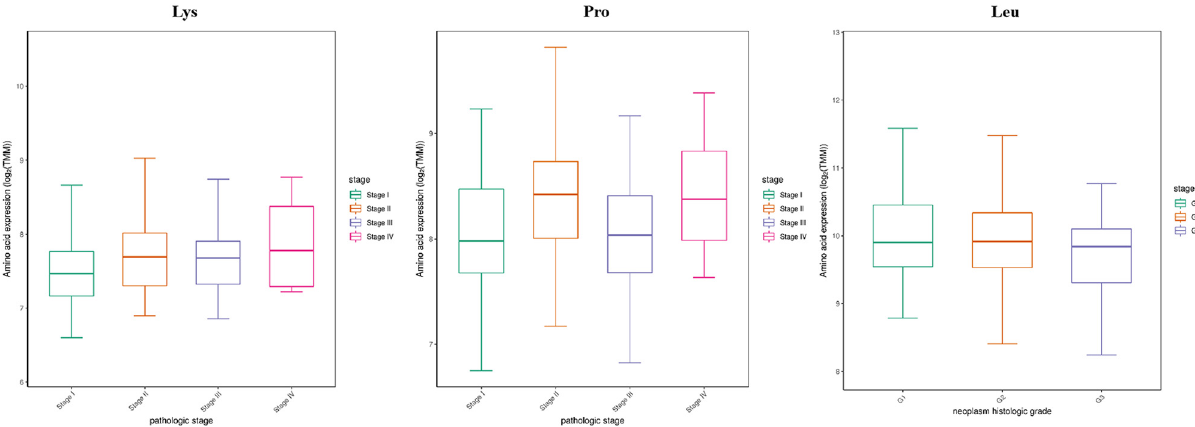
Figure 2: Di ff erentially expressed AAs among di ff erent tumor stages of patients with liver